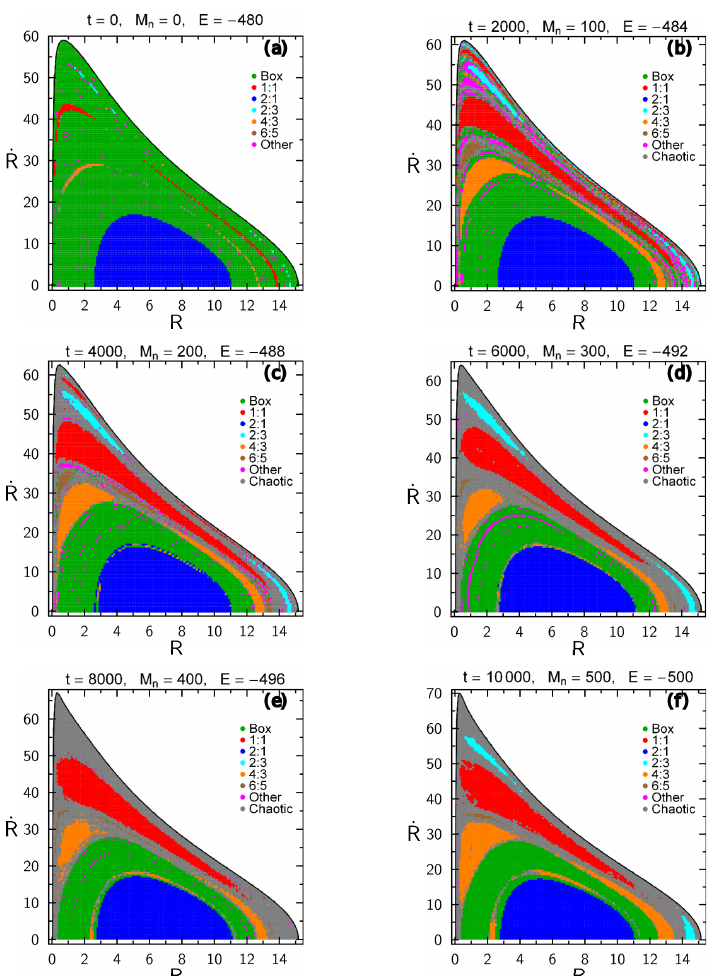
Fig. 4. Orbital structure of the phase ( R; ˙ R ) plane of our galaxy model at several time points of the galactic evolution. drastically in Fig. 4b at t = 2000 time units when M n = 100. It is seen that the box area is significantly reduced and especially at the outer parts of the phase plane there is a strong presence of stability islands of resonant orbits surrounded by a thin chaotic layer. It is interesting to note that inside this chaotic layer one may identify several sets of tiny stability islands corresponding to higher resonant orbits which in our classification belong to the “other” category. The area on the phase plane occupied by these secondary higher resonant orbits is considerably confined when t = 4000 time units and M n = 200. Indeed we see in Fig. 4c that the corresponding stability islands are hardly visible, while at the same time the chaotic zone is amplified. The same pattern continues in Fig. 4d for t =